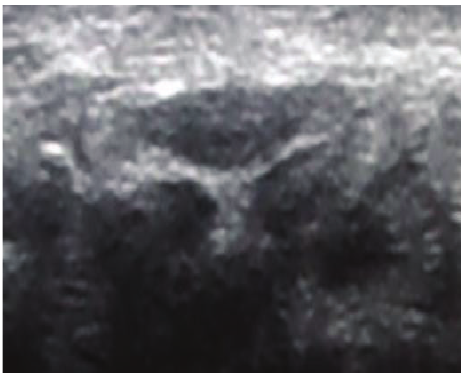
Figure 2: Wrist ultrasound at the carpal tunnel inlet for patient with moderate CTS, the cross sectional area of the median nerve was 14mm 2 .